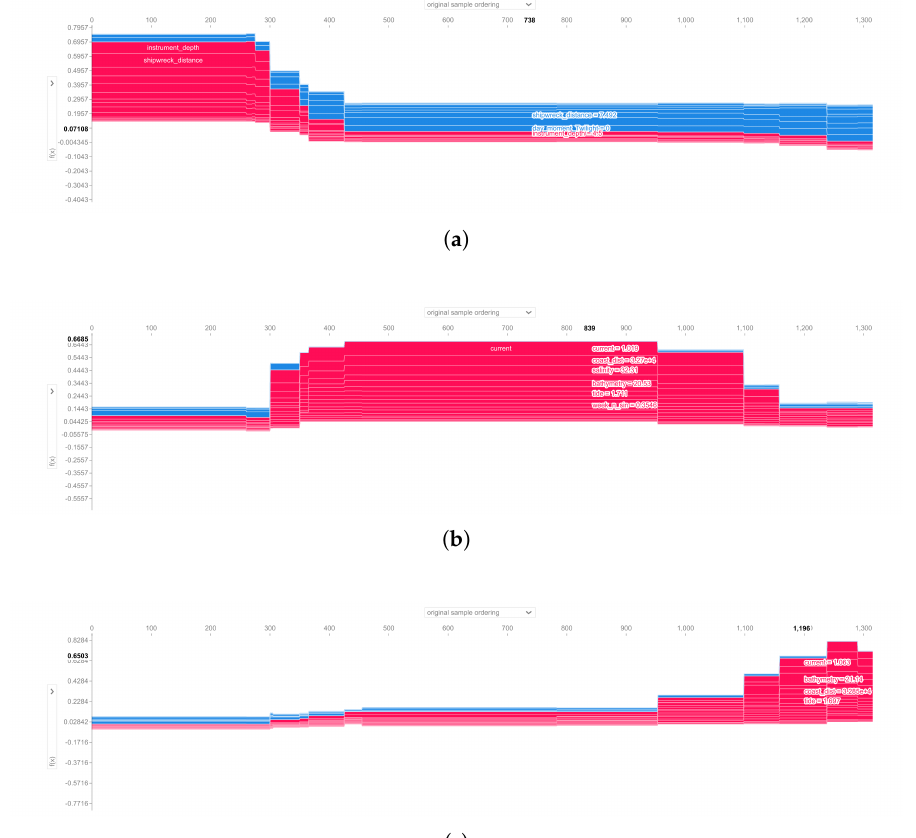
Figure 11. SHAP plots showing samples’ probability of belonging to classes 3 ( a ), 13 ( b ) and 6 ( c ). The x axis is the time in samples; the y axis is the probability of a sample to be classified as a specific class. Blue probabilities are negative influences, and red probabilities are positive influences of a